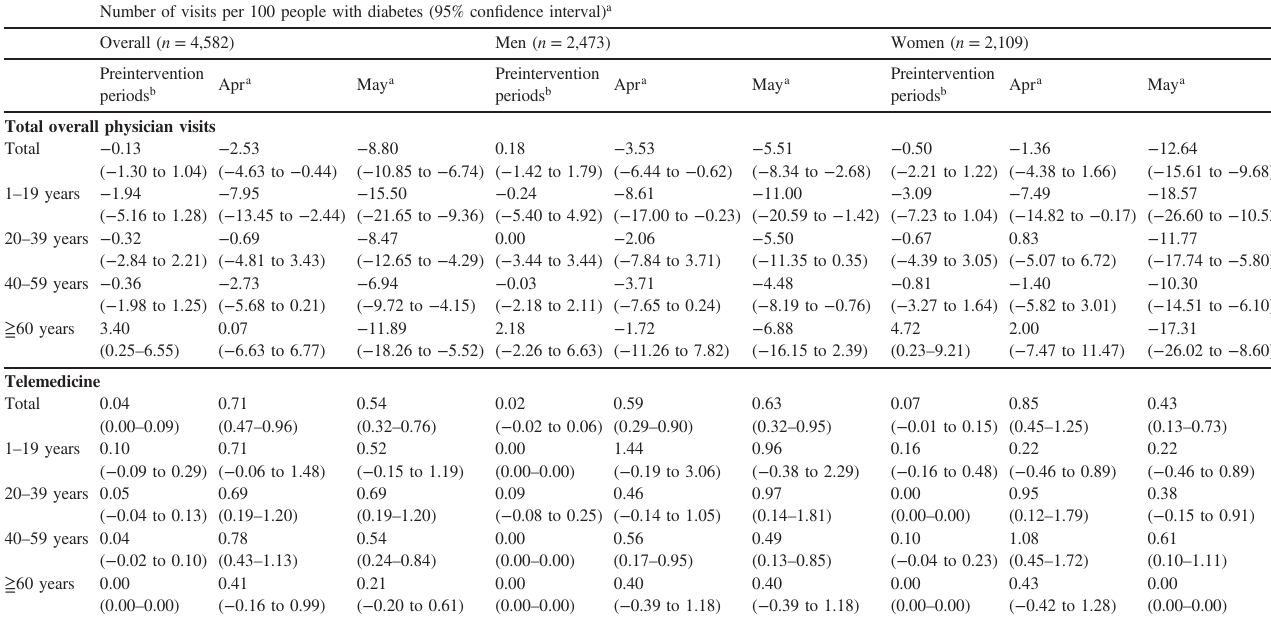
Table 2. Di ff erence-in-di ff erence model: Total and telemedicine visits 2020 vs 2019 for patients with type 1 diabetes Number of visits per 100 people with diabetes (95% con fi dence interval) a Overall ( n = 4,582)